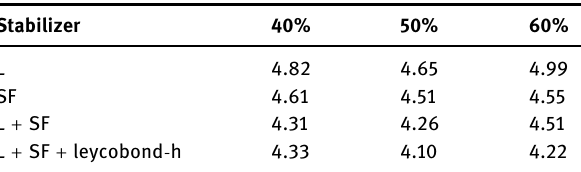
Table 4: Final settlement ( mm ) with di ff erent stabilizer slurries under 80 N